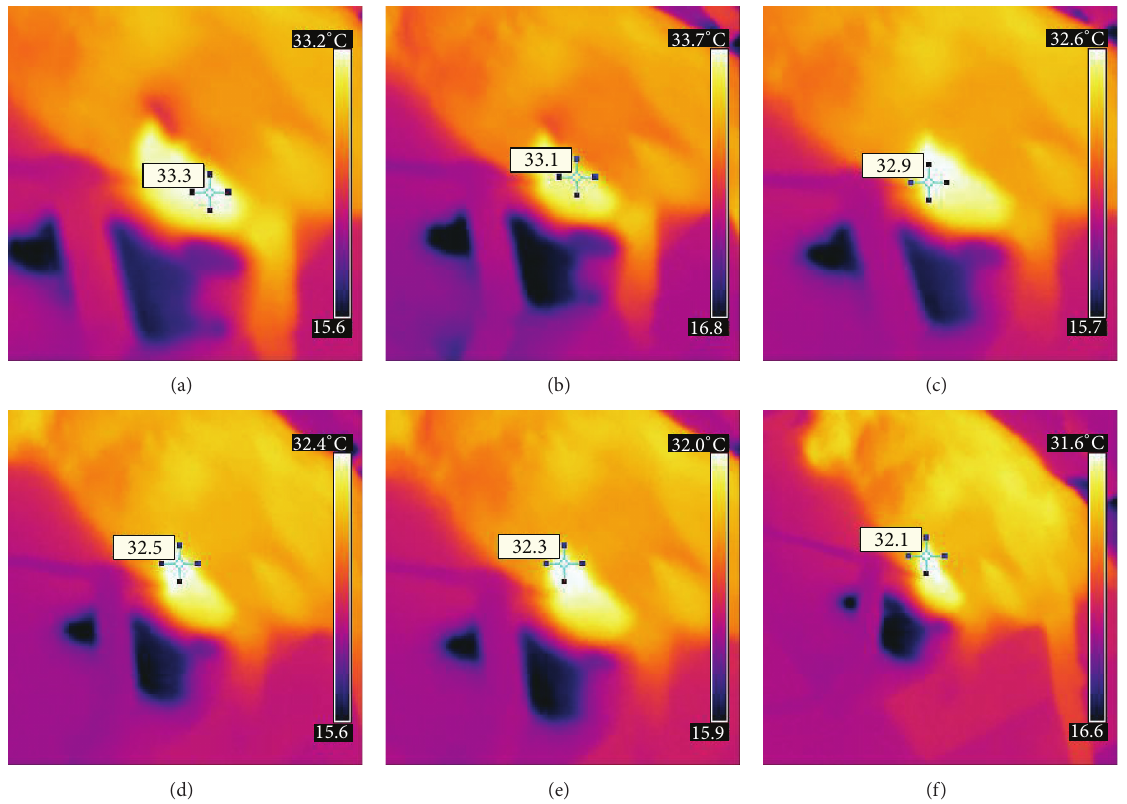
Figure 6: Six thermal images from an anesthetized rat before (a), during ((b)–(d)), and after ((e) and (f)) red light stimulation at the left Zusanli acupoint. Note the decrease of the temperature during and after red light